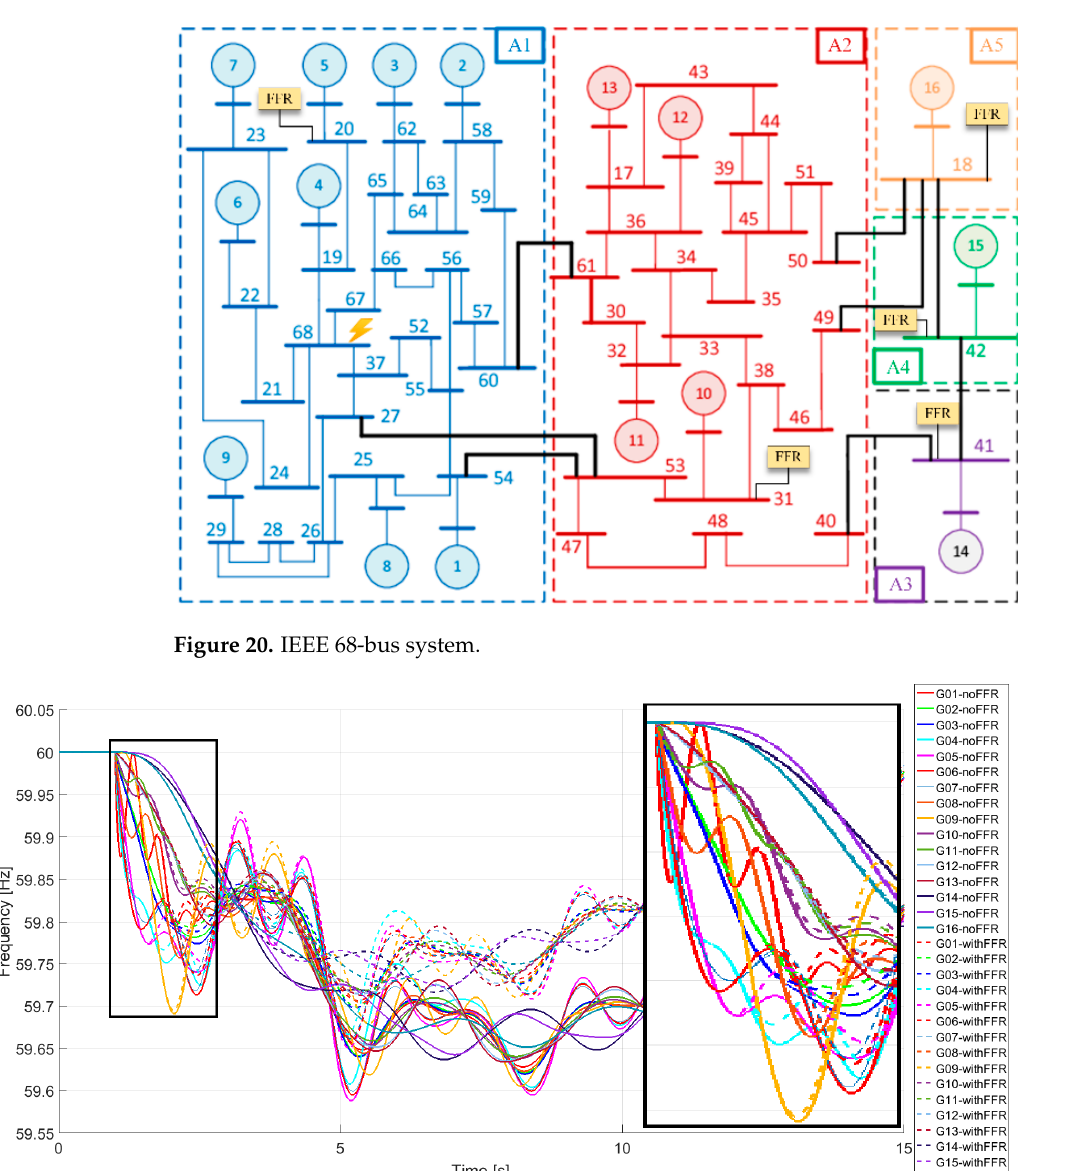
Figure 21. Frequencies at generator buses after disturbance in Area